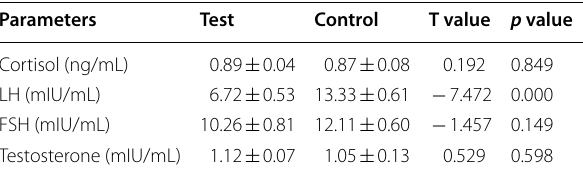
Table 3 Serum hormone among prostate cancer patients and controls